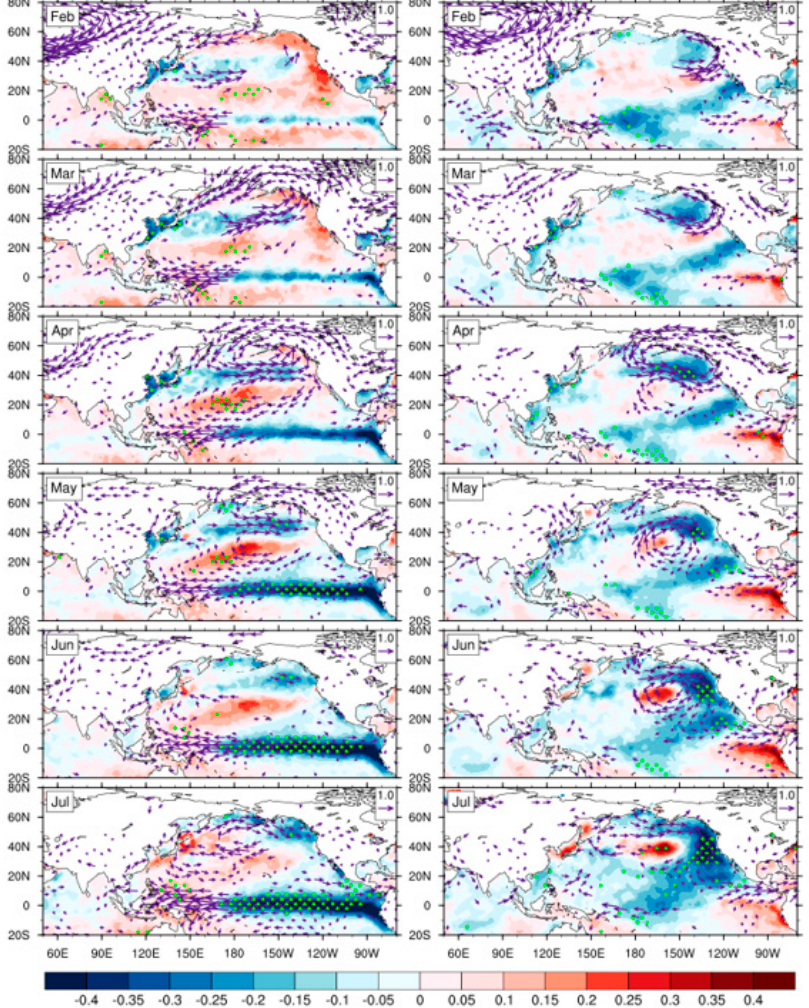
Figure 6. Monthly evolving spatial patterns of the JFM-SH-index-regressed 850 winds (vectors, exceeding the 95% significance level based on the two-sided Student’s t -test, unit: m/s) and SST (shading, ◦ C) anomalies from February to July during (left panel) 1980–2002 and (left panel) 2003–2020. The green dots denote the significant SST anomalies above the 95% confidence level based on the two-sided Student’s t-test.